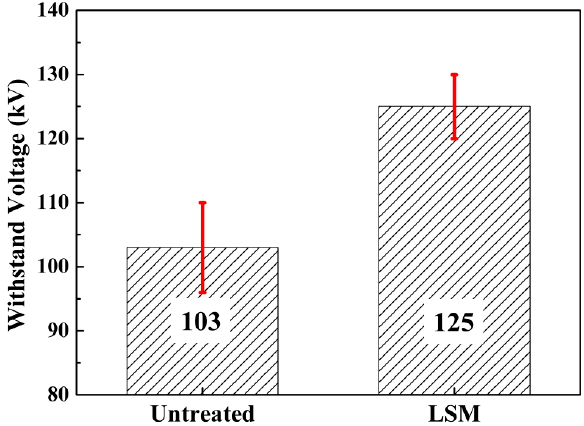
Figure 9. Withstanding voltage values for the untreated and LSM-treated contacts.